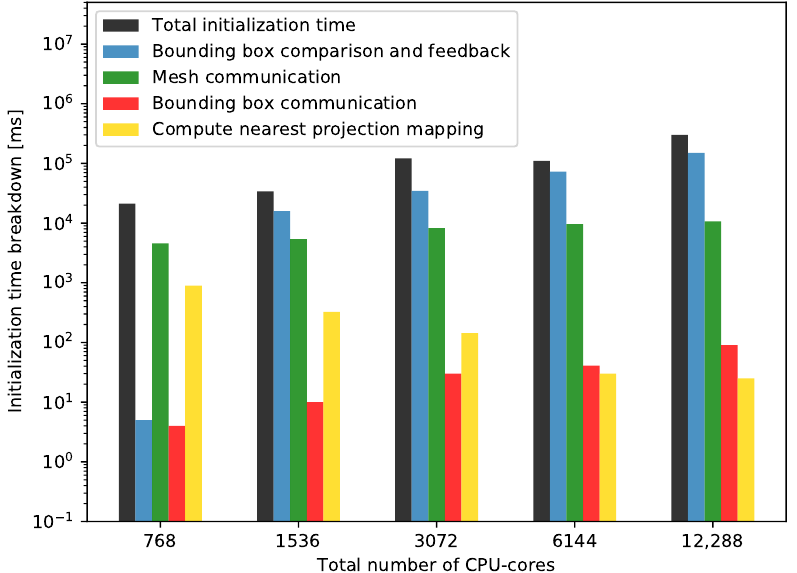
Figure 11. Strong scalability measurements: Initialization time breakdown for the two-level initializa- tion approach using mesh M5 for solver A and mesh M6 for B. Only parts significantly contributing to the runtime are depicted: 1—Bounding box comparison and feedback (Figure 1 levels IV and V). 2—Mesh communication (Figure 2 levels II). 3—Bounding box communication (Figure 1 levels II and III). 4—Compute nearest projection mapping (Figure 2 level II).